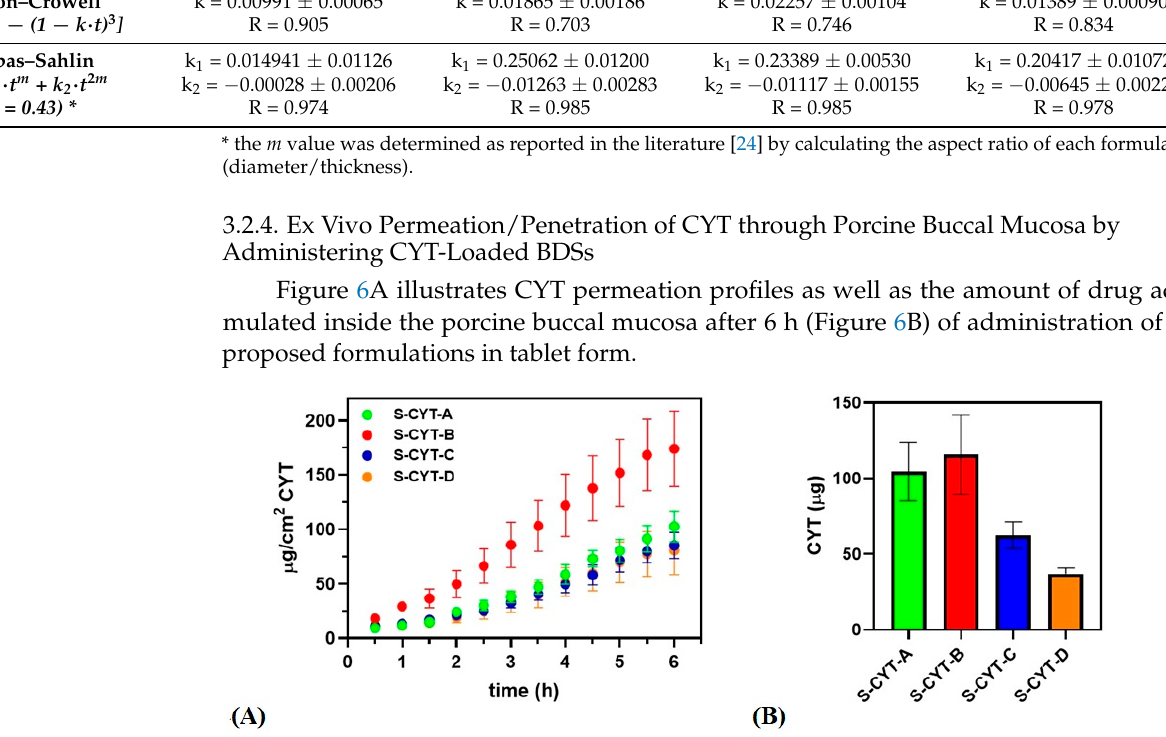
Figure 6. Permeation/penetration results of administering S-CYT-A (green), S-CYT-B (red), S-CYT-C (blue) and S-CYT-D (orange). ( A ) CYT ( µ g/cm 2 ) permeated as a function of incubation time (h) and ( B ) CYT ( µ g) accumulated into the buccal membrane after 6 h. Results are presented as means ± SE (n =